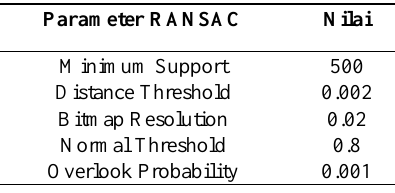
Table 3. RANSAC parameter value which are used in PolyFit Software